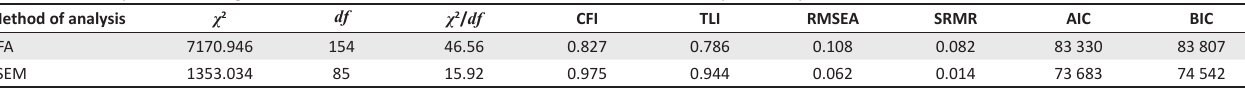
TABLE 3: Summary of combined goodness-of-fit statistics for the various South African Personality Inventory models. Method of